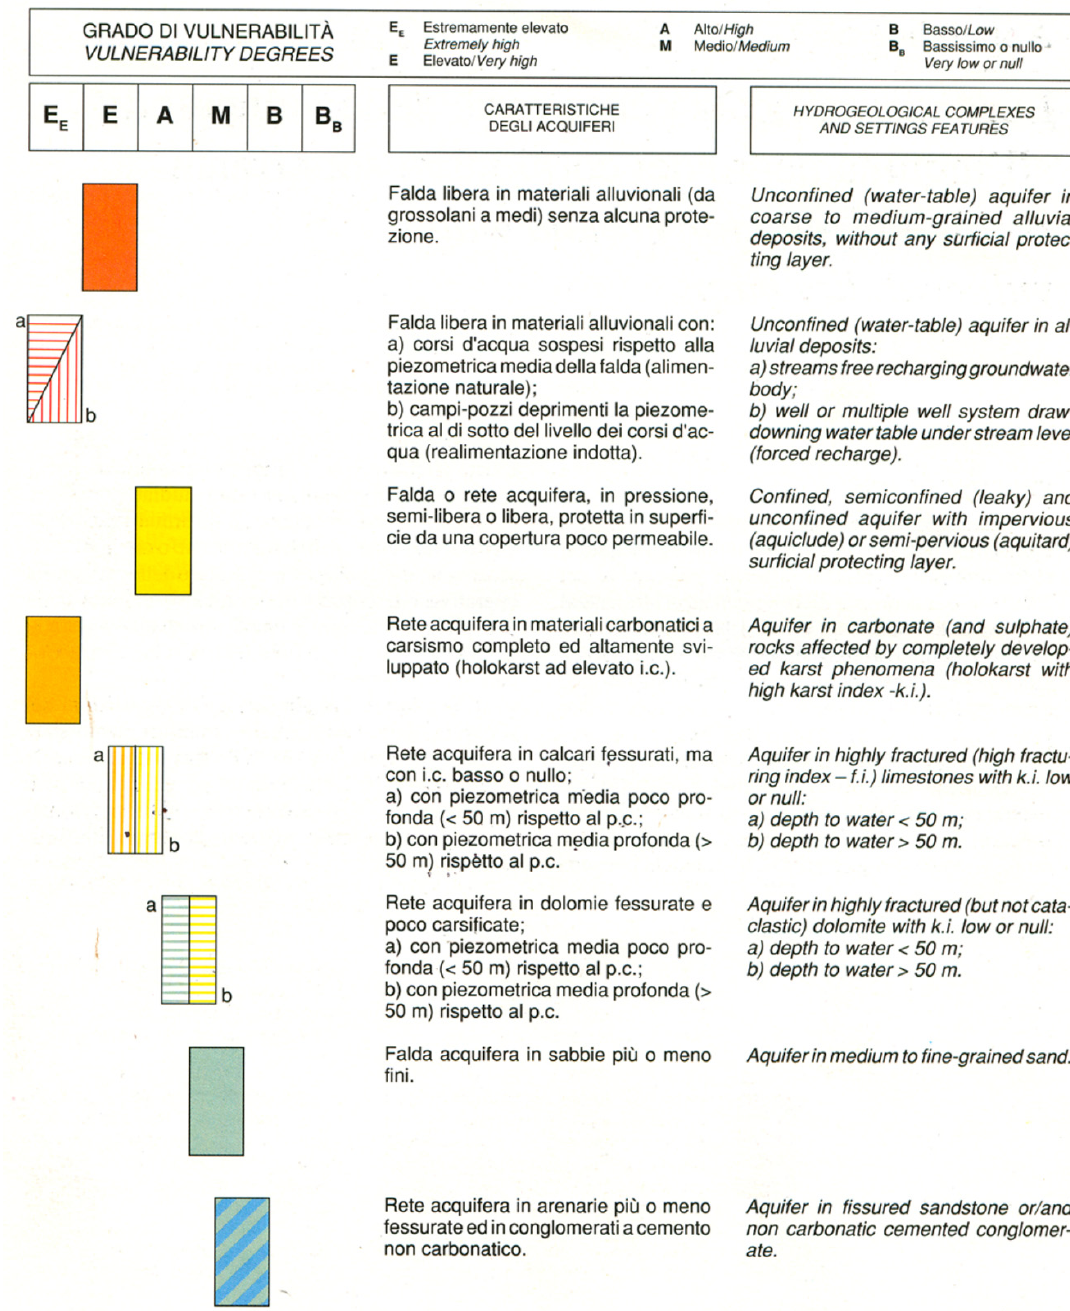
Figure 2. Protocol for assessing the intrinsic vulnerability of aquifers with the GNDCI-CNR method